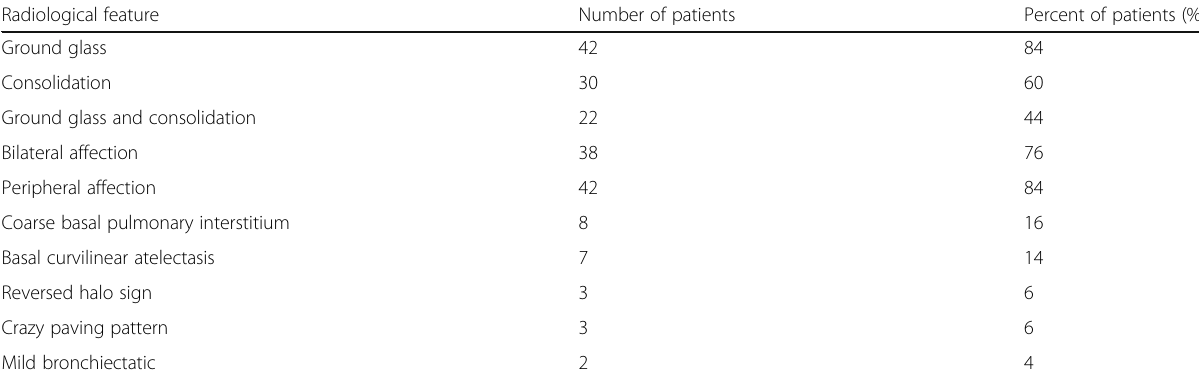
Table 2 Different spectrum of radiological features Radiological feature